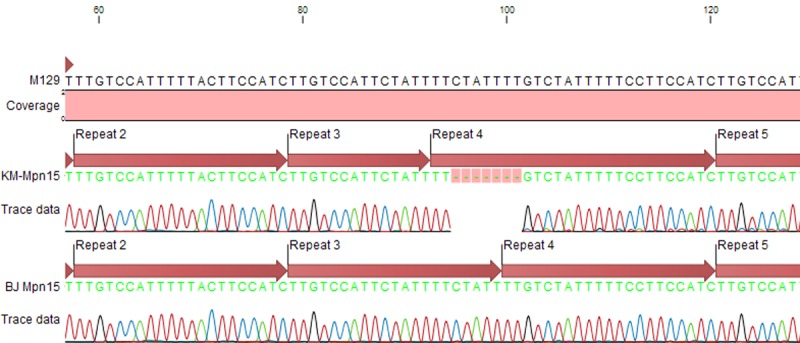
Sequence comparison of the locus Mpn 15.M129, M. pneumoniae reference strain; KM-Mpn15, the special sequence of Mpn15 from Kunming; BJ-Mpn15, the normal sequence of Mpn15 from Beijing; all repeat sequences in Mpn15 were 21-bp-long, except repeat 3, which was a 14-bp-long truncated sequence.